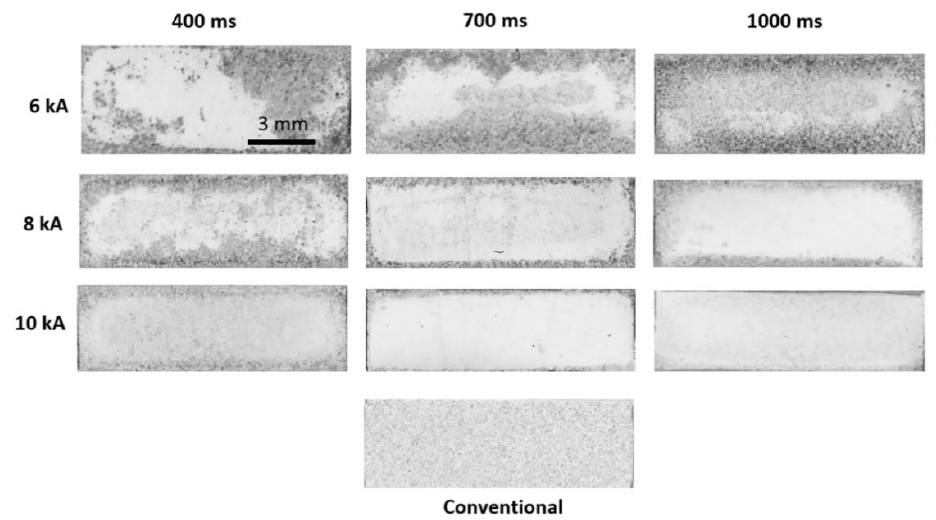
Figure 6. Porosity distribution in MF-ERS and conventionally processed iron compacts. The denser and thus more reflecting clear areas indicate a lower porosity.